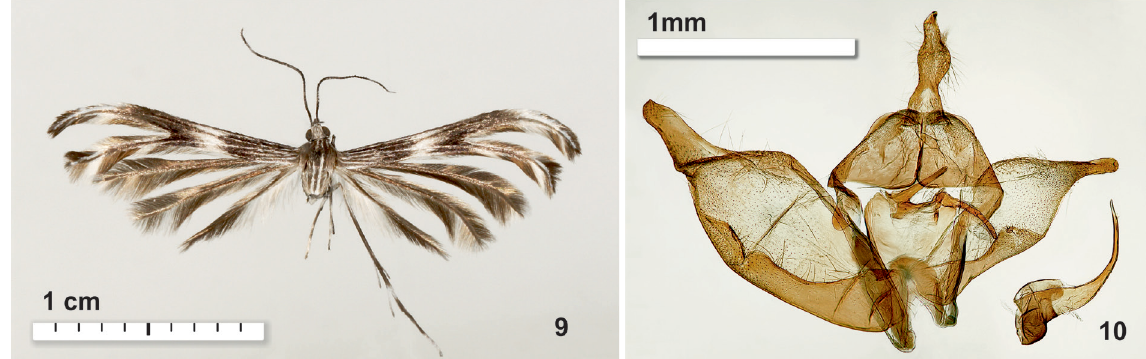
Figs 9–10. Singularia tolima Kovtunovich & Ustjuzhanin sp. nov. 9 . Holotype (ZISP 1839). 10 . Holotype, genitalia (ZISP